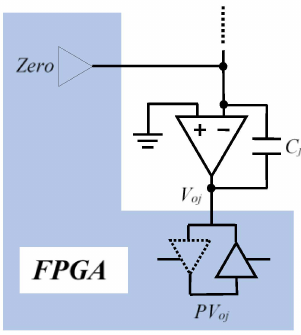
Figure 2. FPGA pins which charge the capacitor in the CHARGE